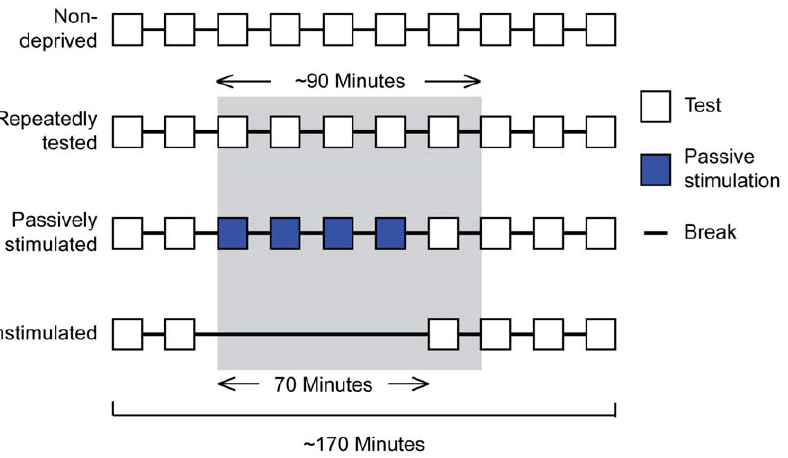
Figure 4. Experiment 2 conditions. One group of non-deprived and three groups of visually deprived participants were tested on the GOT (white squares). In the passively stimulated group, participants received grating stimuli that they were not required to discriminate (blue squares). Blocks were separated by 8-minute rest periods (short horizontal lines). The shaded rectangle indicates the period of visual deprivation. The experiment duration was approximately 170 minutes.